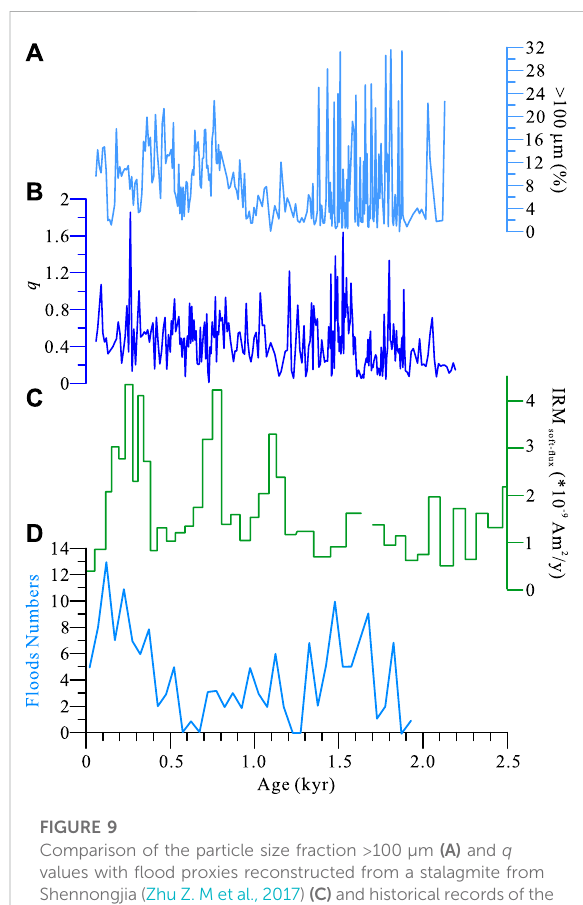
FIGURE 9 Comparison of the particle size fraction > 100 µm (A) and q values with fl ood proxies reconstructed from a stalagmite from Shennongjia (Zhu Z. M et al., 2017) (C) and historical records of the Yangtz River delta (D) (Nian et al.,